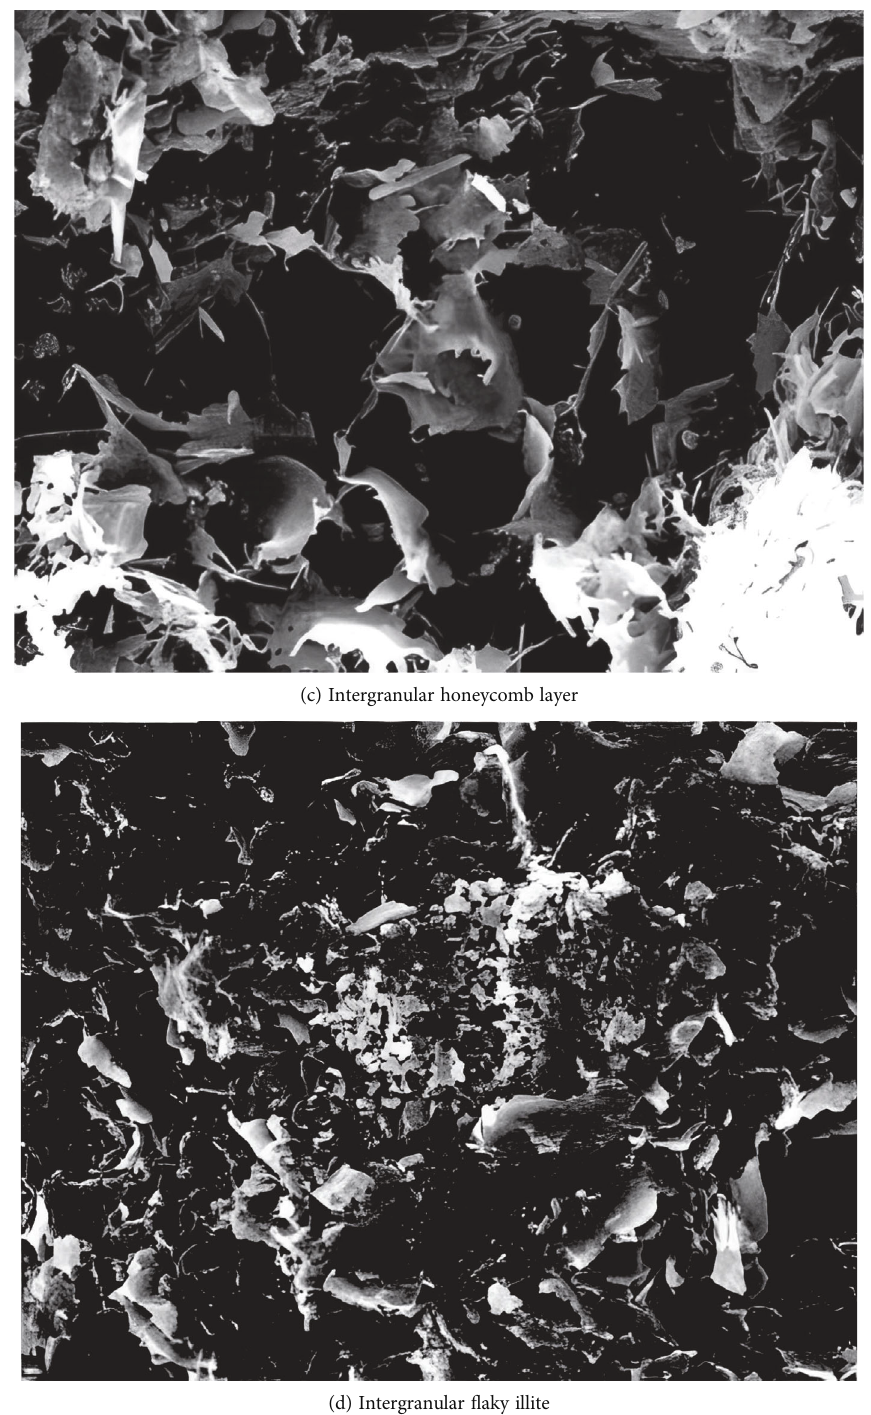
Figure 2: Core electron microscopic diagram of Liu 1 formation in Weizhou 11-4N oil fi eld (Wang Yanxing,